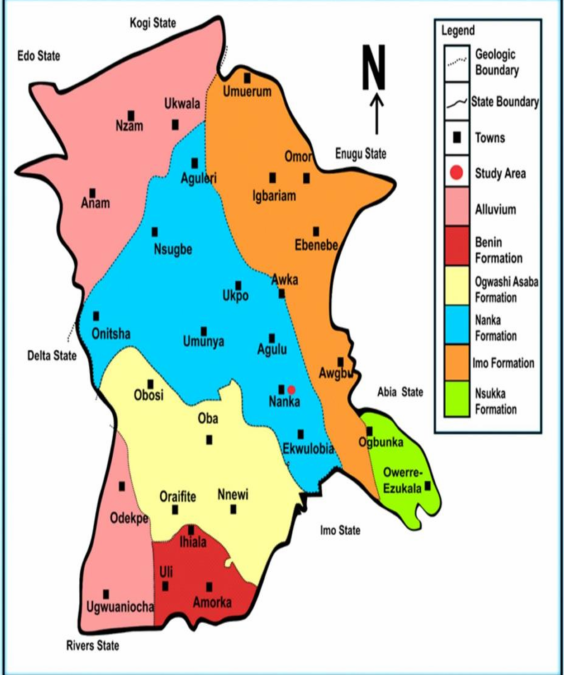
Fig. 1. Geologic map of Anambra State showing study areas [27]